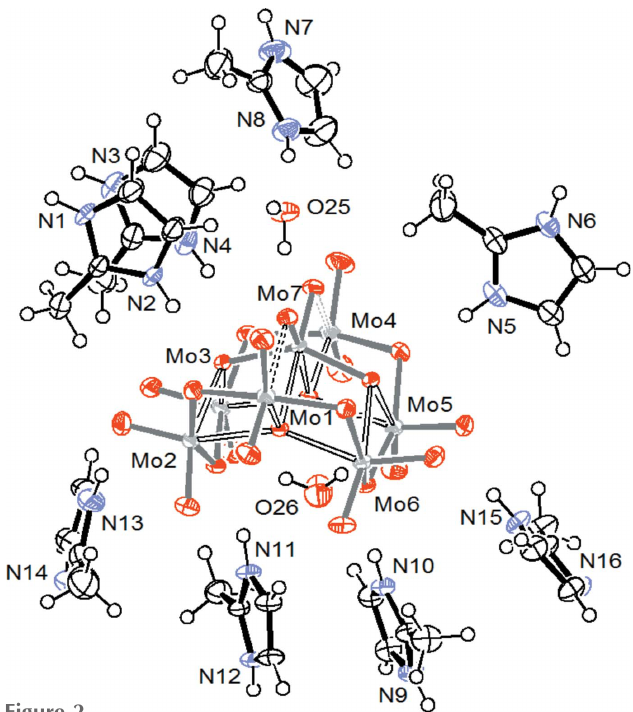
Figure 2 The asymmetric unit of (I) with displacement ellipsoids drawn at the 50% probability level.